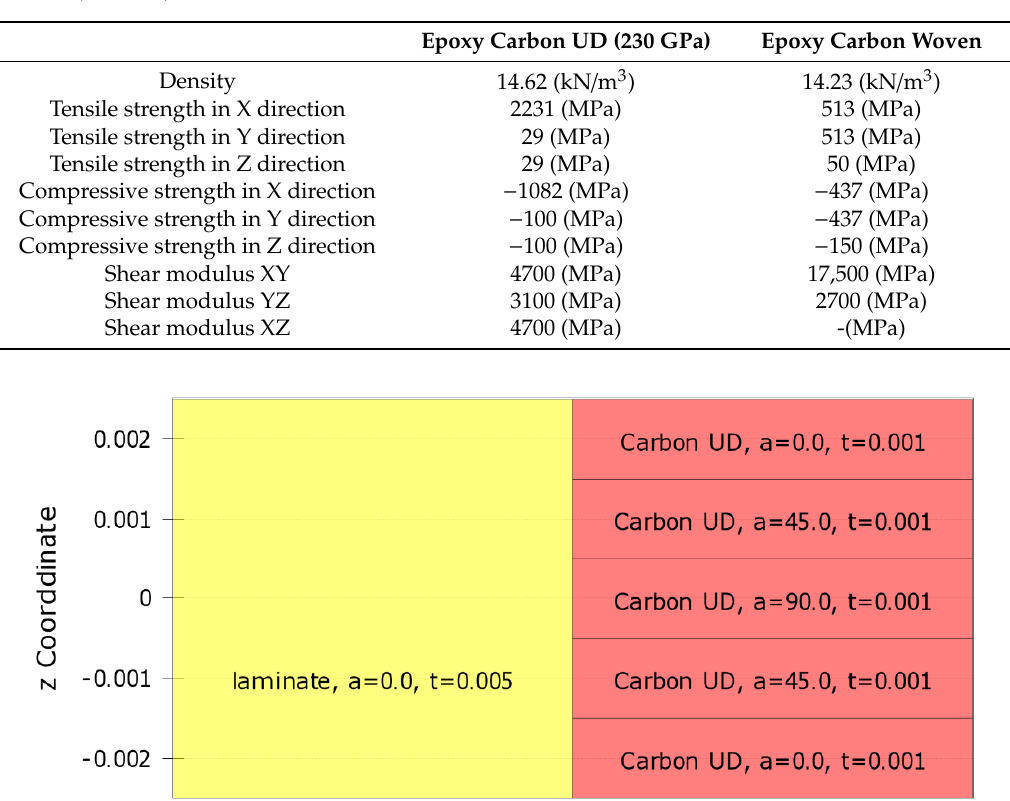
Table 2. The material properties and strength parameters of epoxy carbon unidirectional (UD) and woven (230 GPa).